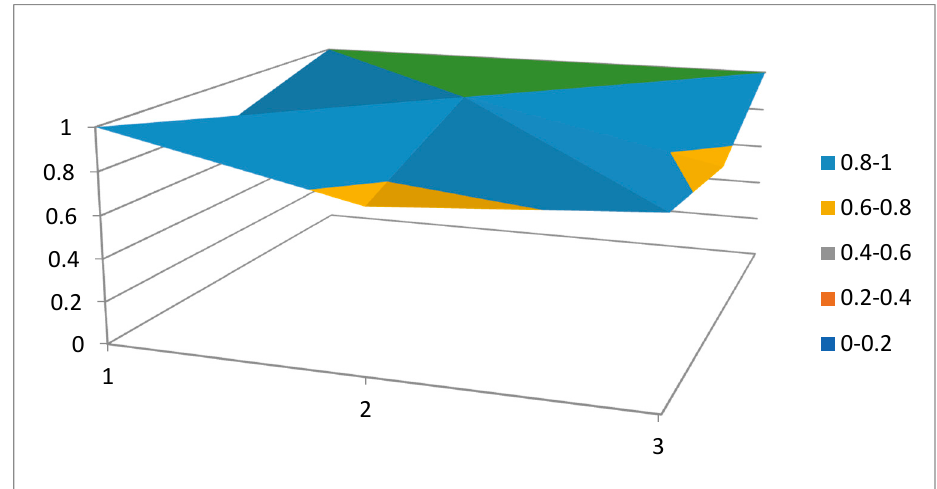
Figure 5. PMC surface of pig price control policy P2.